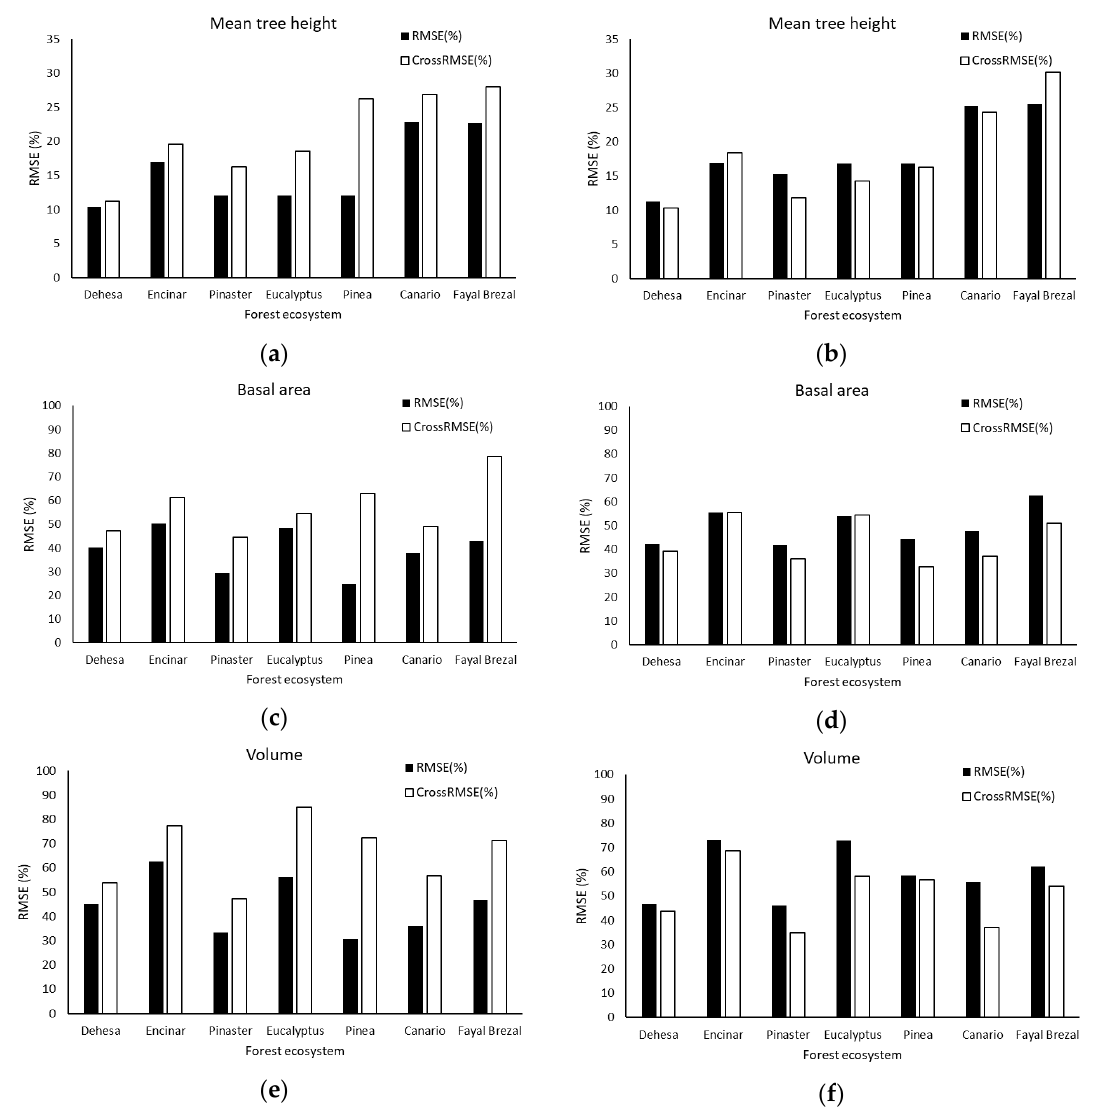
Figure 5. Model performance for mean tree height ( a and b ), stand basal area ( c and d ) and growing stock volume ( e and f ) expressed as the relative root mean squared error (RMSE%) when using high-accuracy positioning ( POS HA , left) and low-accuracy positioning ( POS LA , right). The CrossRMSE% represents the model error (RMSE%) when using POS HA models with POS LA datasets in left sub-figures ( a , c and e ), while the right-subfigures ( b , d , f ) refer to using POS LA models with POS HA